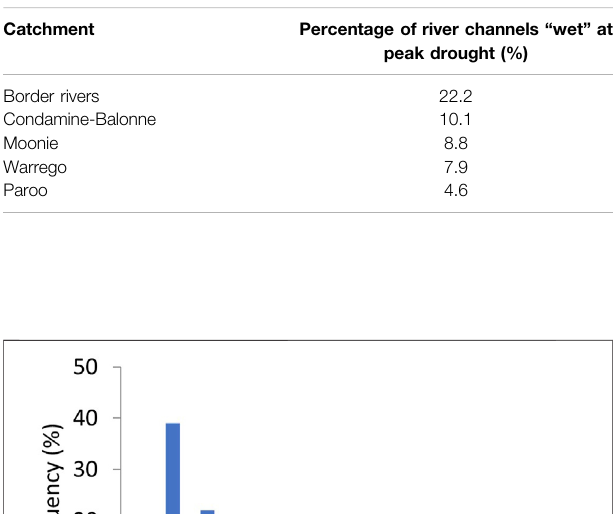
TABLE2| Thepercentageoftheriverchannelnetworkthatretainedsurfacewater in waterholes ( ‘ wet ’ ) at the peak of the 2018 – 2020 drought in each QMDB river system.